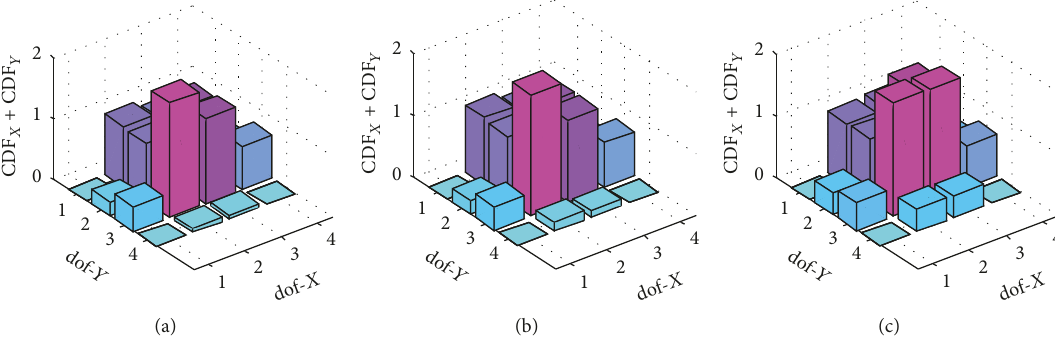
Figure 5: Effect of the noise in CDF calculated for DS3 versus DS0 for a 16-dof model. (a) 0% noise, (b) 5% noise, and (c) 10% noise.